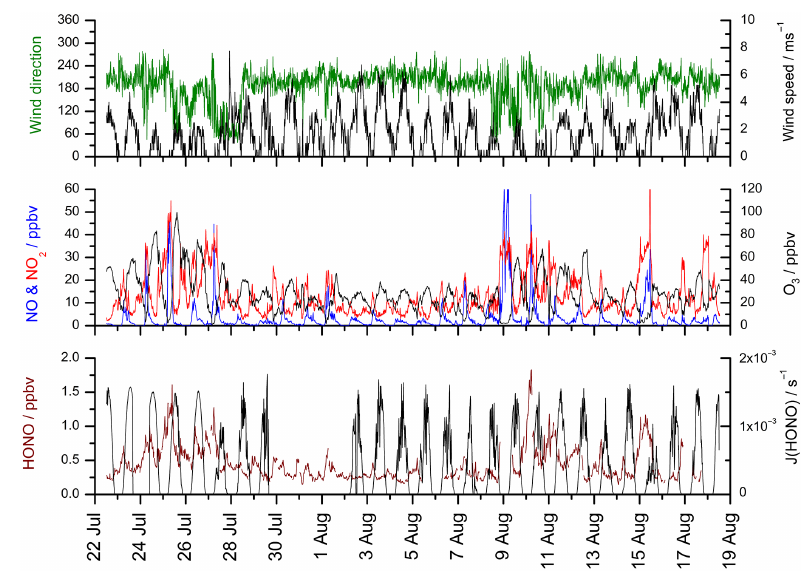
Figure 1. Time series of selected data from the ClearfLo intensive operation period (July and August 2012). The top panel shows wind speed (black) and wind direction (green); the middle panel shows NO (blue), NO 2 (red), and O 3 (black); the bottom panel shows HONO (dark red) and j (HONO) (black). All data are 15 minute averaged and plotted as UTC (local time − 1h).